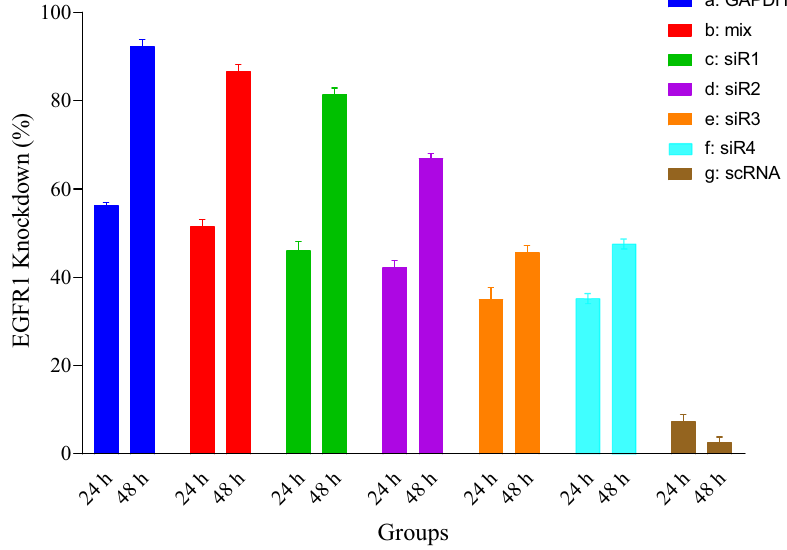
Figure 8. Quantitative PCR of MDA-MB-231 cells after 24 and 48 h after transfection of siRNA@ [FA-PEGylated/PEI@GuIL@KIT-6]. (a) RT-qPCR analysis for positive control (GAPDH) shows about 92%, (b) for cocktail (mix) siRNAs shows about 87%, (c) for siR1 about 81%, (d) for siR2 about 67%, (e) for siR3 about 45% and (f) for siR4 about 48% knockdown of baseline expression of EGFR1 gene. (g) For scrambled RNA (scRNA) no significant change in expression level was